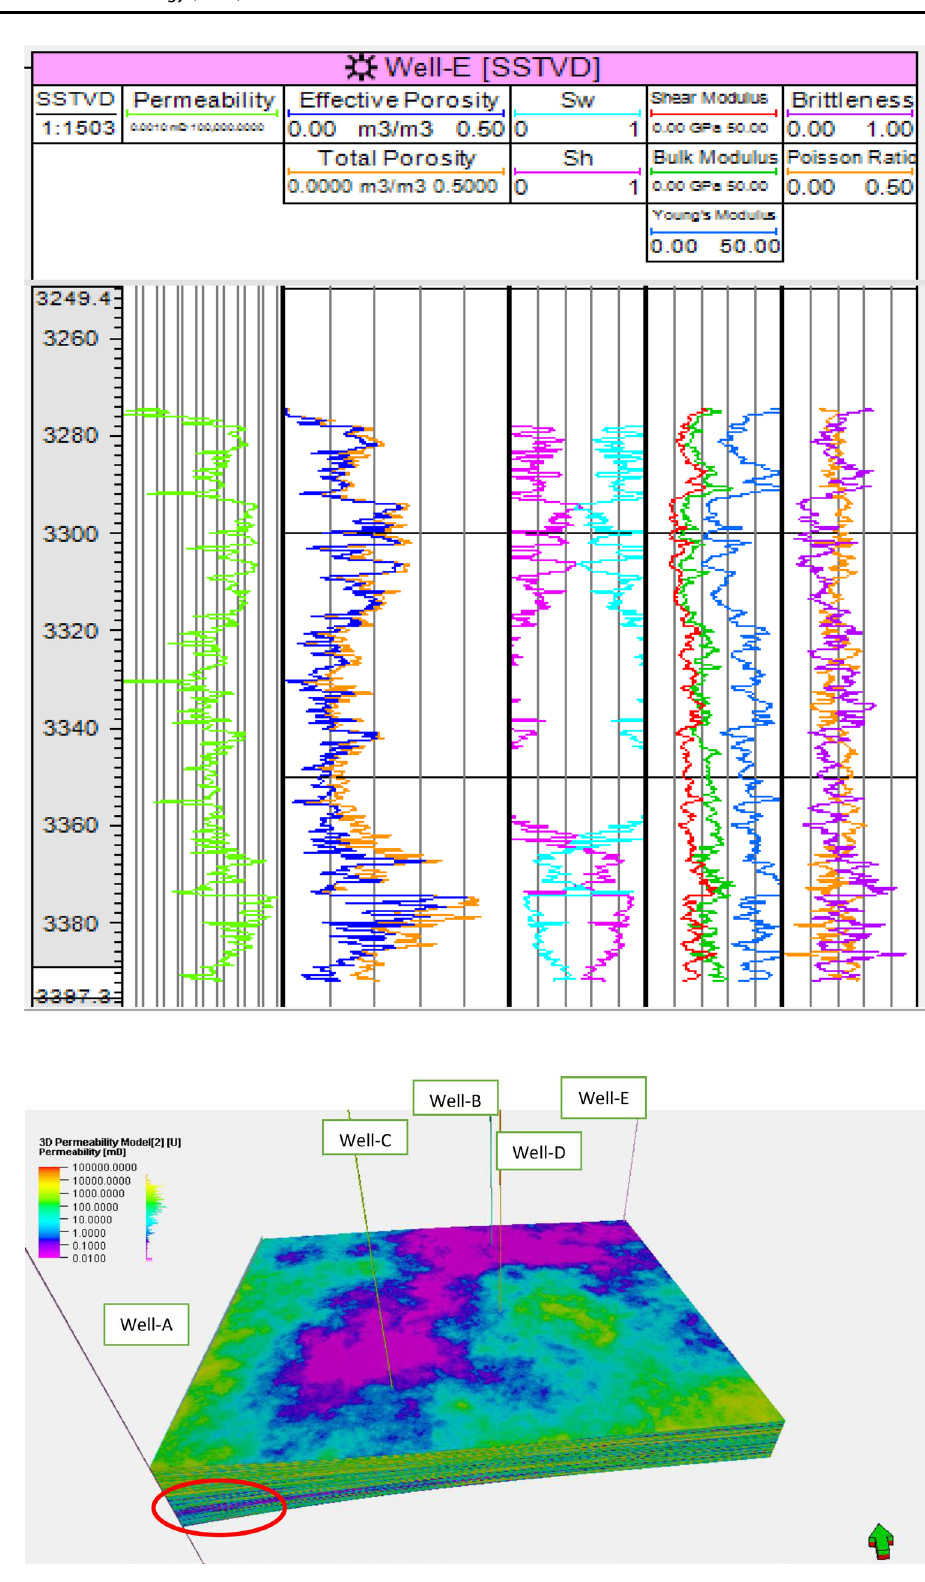
Fig. 16 Petrophysical and geomechanical properties of the Well-E